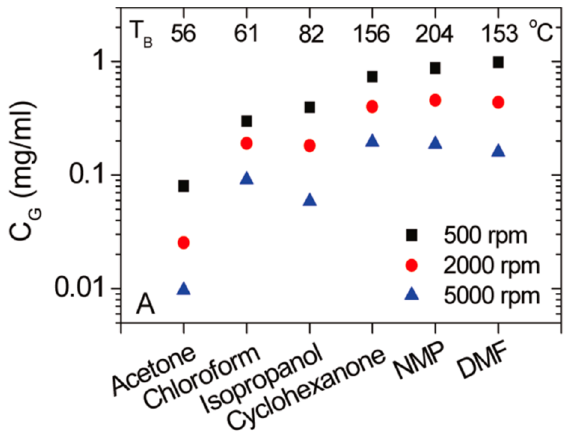
Figure 18. Concentration of dispersed graphene as a function of centrifugation rate for three high-boiling-point and three low-boiling-point solvents. The boiling points are given at the top of the figure. Reproduced from [84]. Copyright Elsevier, 2014.